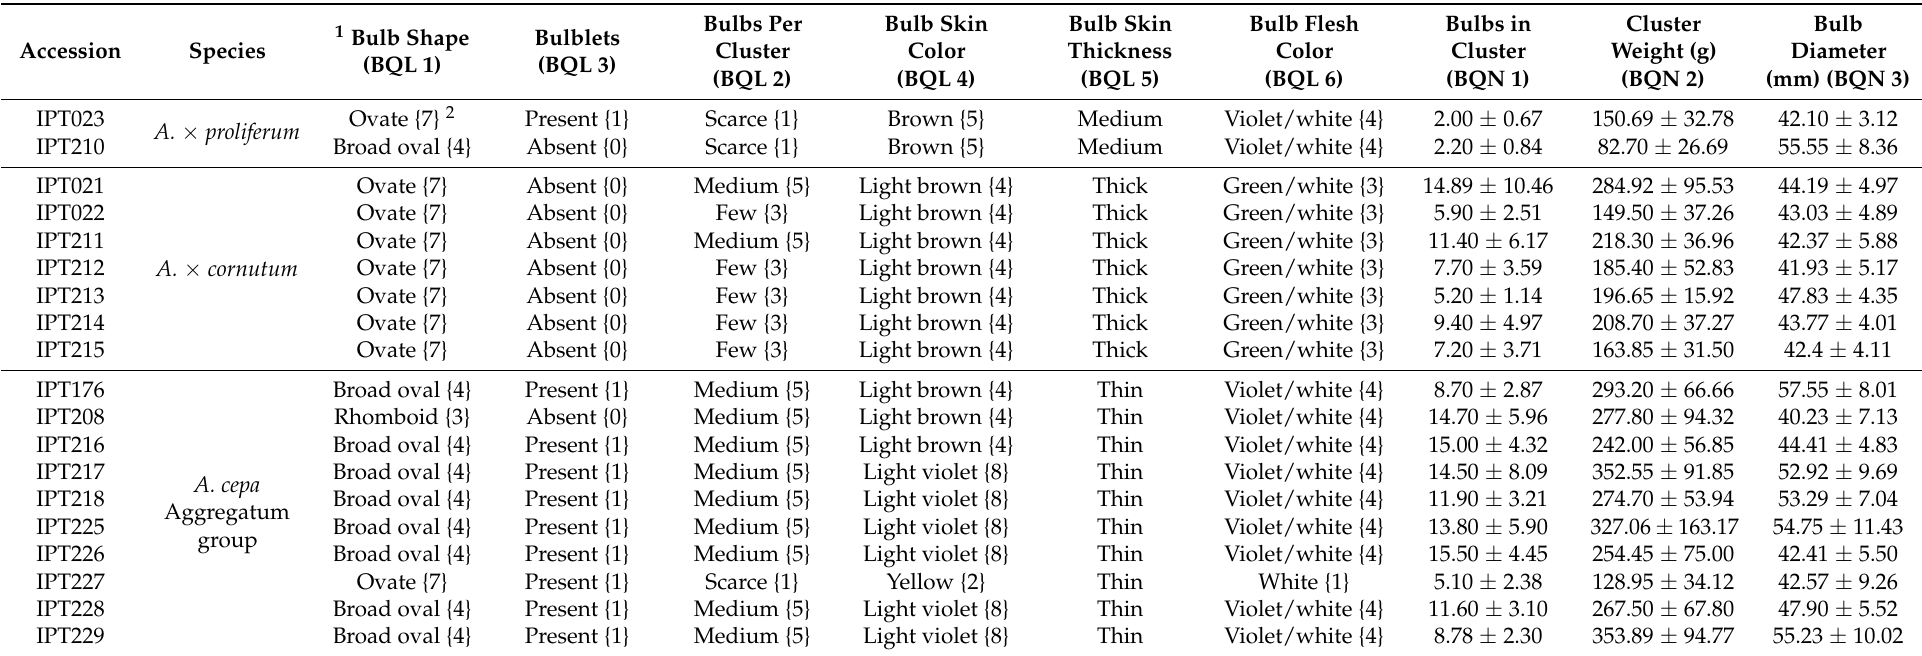
Table 4. Qualitative and quantitative bulb morphology descriptors for all 35 shallot